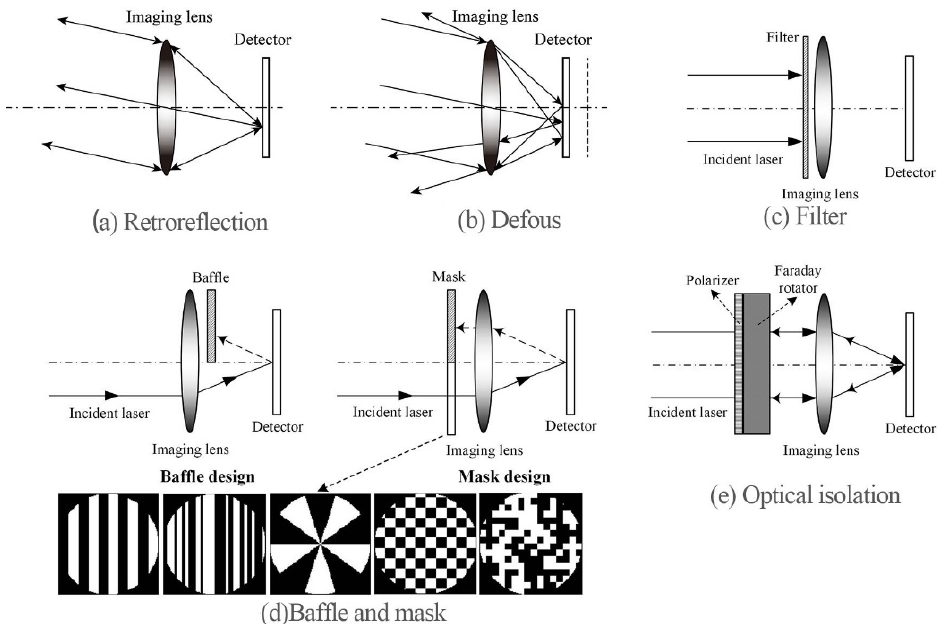
Figure 1. ( a ) The principle of retroreflection effect and ( b – e ) a few methods to reduce the strength of the retroreflected signal.